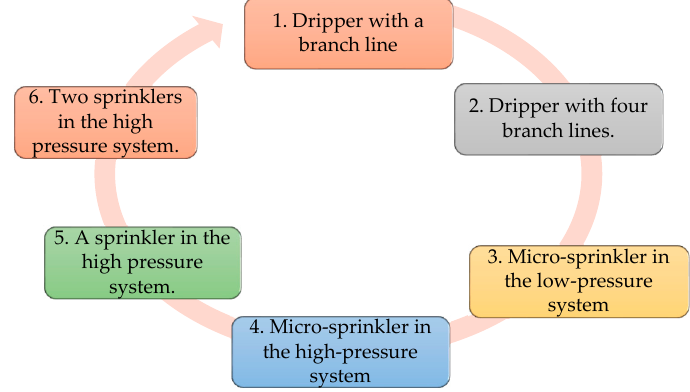
Figure 1. Obtaining experimental data.